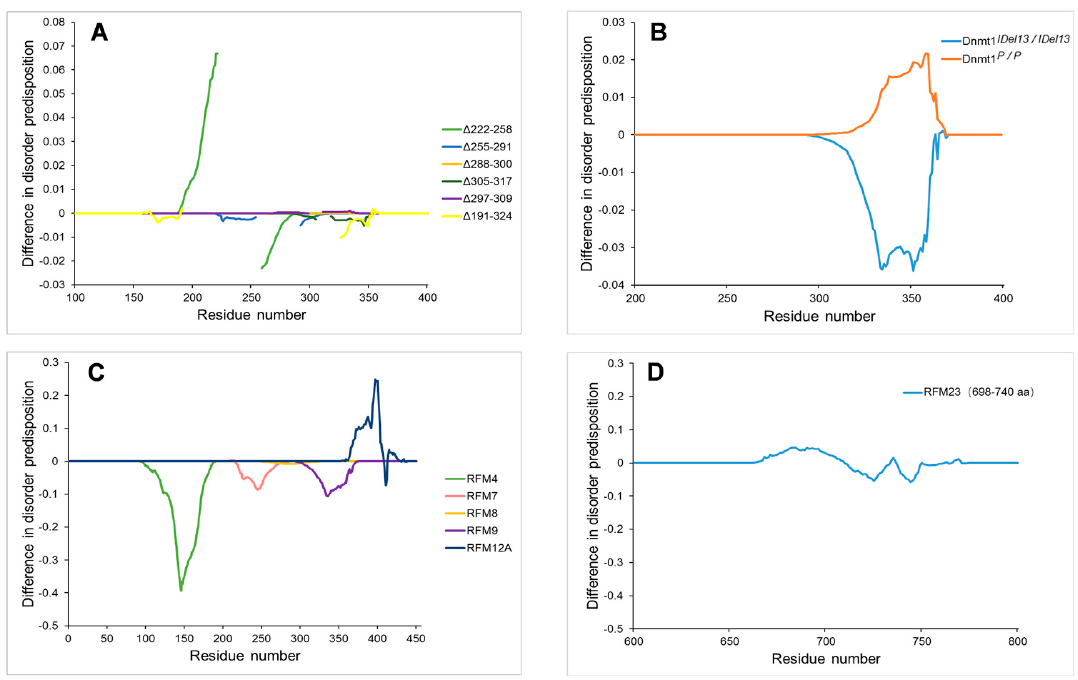
Figure 9. Difference disorder spectra calculated based on the effect of various mutations on intrinsic disorder propensity of mouse DNA methyltransferase (cytosine-5) 1 (DNMT1). The effects of six deletion mutations ( A ) two substitution mutations ( B ) and six regional frame-shift mutagenesis (RFM) mutations ( C , D ) on the local disorder propensity of mouse DNMT1.